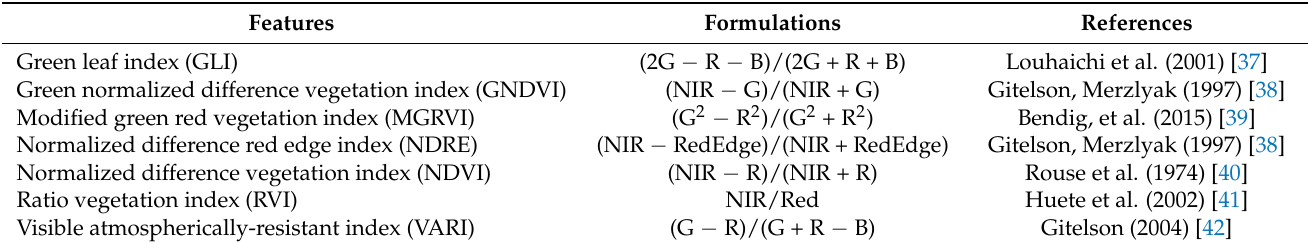
Table 3. Descriptions of vegetation indices used for LAI, nitrogen, and fresh biomass estimation in this study.